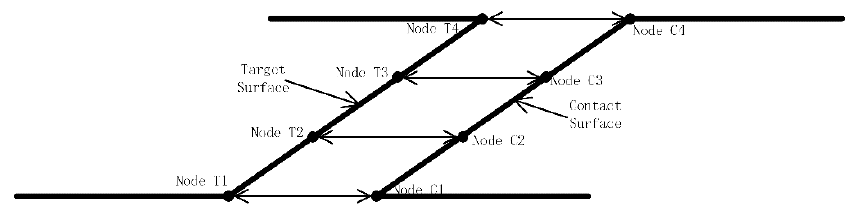
Figure 2. Schematic diagram of face-to-face contact model.